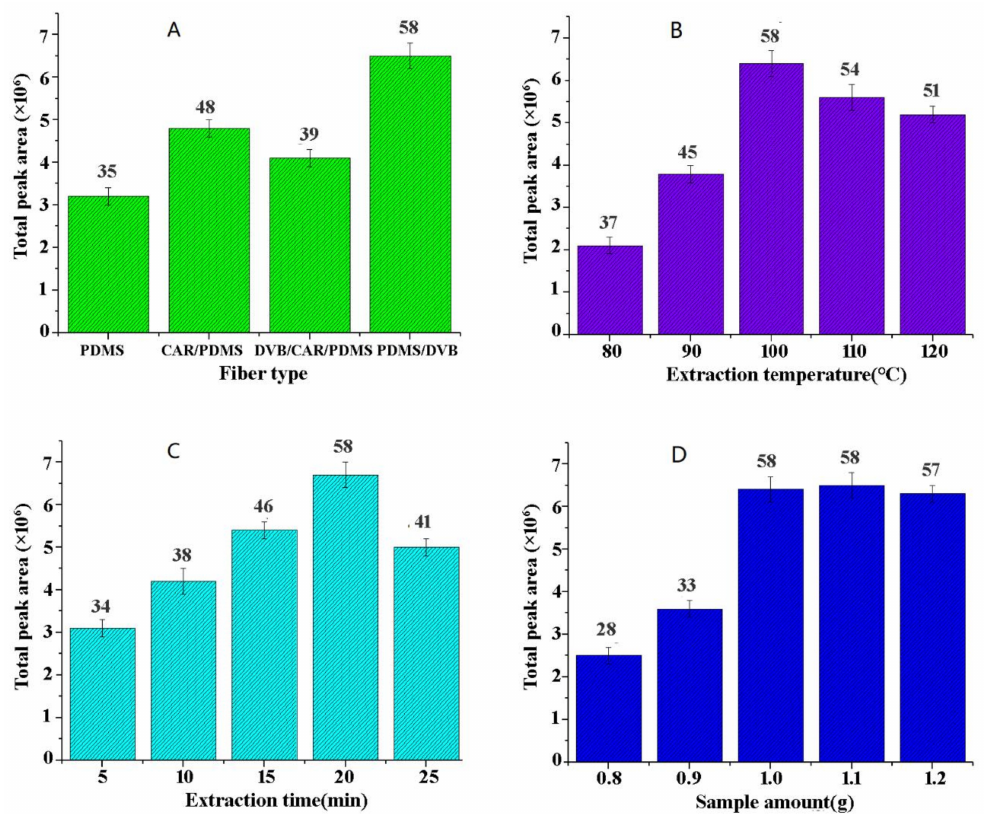
Figure 1. E ff ects of extraction parameters on the volatiles of Selaginella doederleinii . ( A ) solid phase microextraction (SPME) fiber; ( B ) extraction temperature; ( C ) extraction time; ( D ) sample